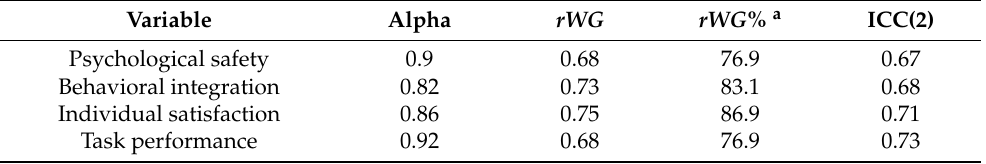
Table 3. Cronbach’s alpha, mean rWG, rWG percentage, ICC(2) for all